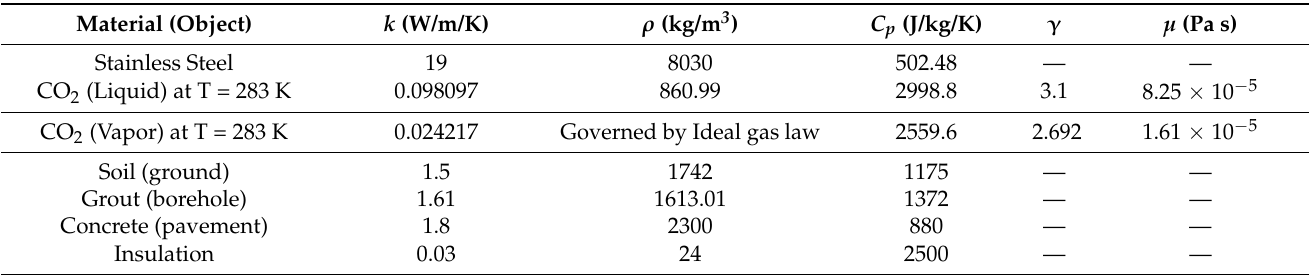
Table 1. Model material